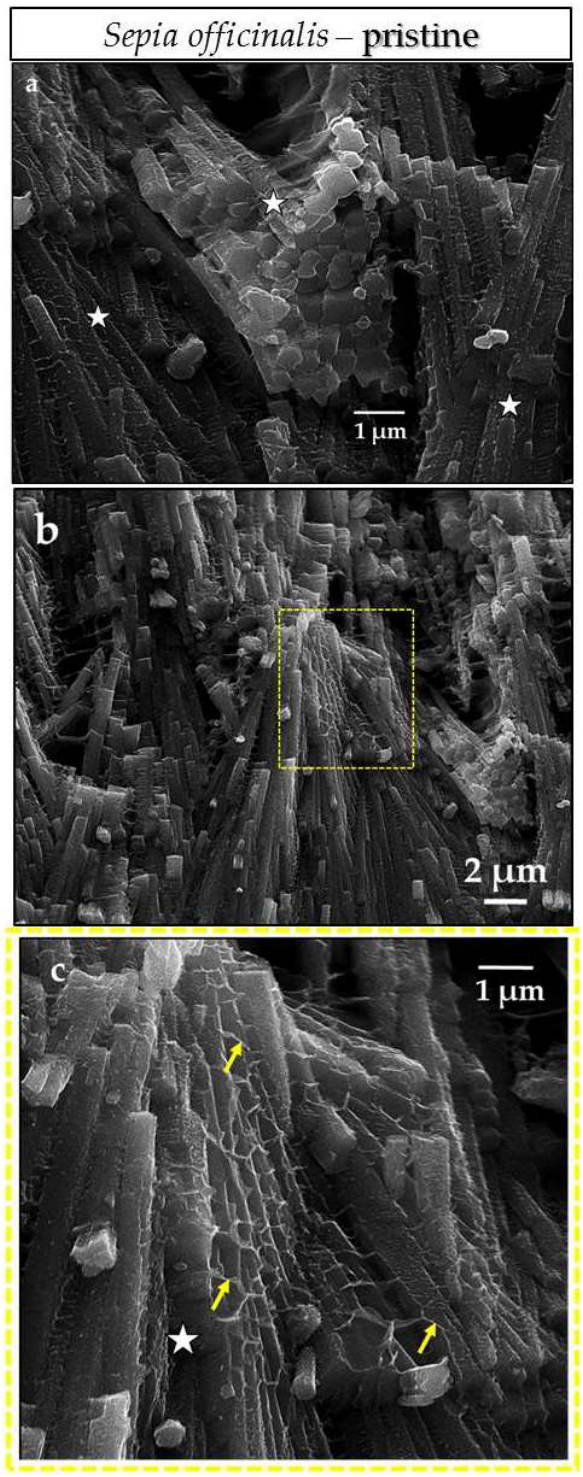
Figure A12. FE-SEM images of arrays of aragonite rods (white stars in ( a , b )) within pristine Sepia officinalis cuttlebone platforms. Each rod is a composite of a biopolymer matrix (or scaffold, yellow arrows in ( b )) filled with aragonitic mineral.